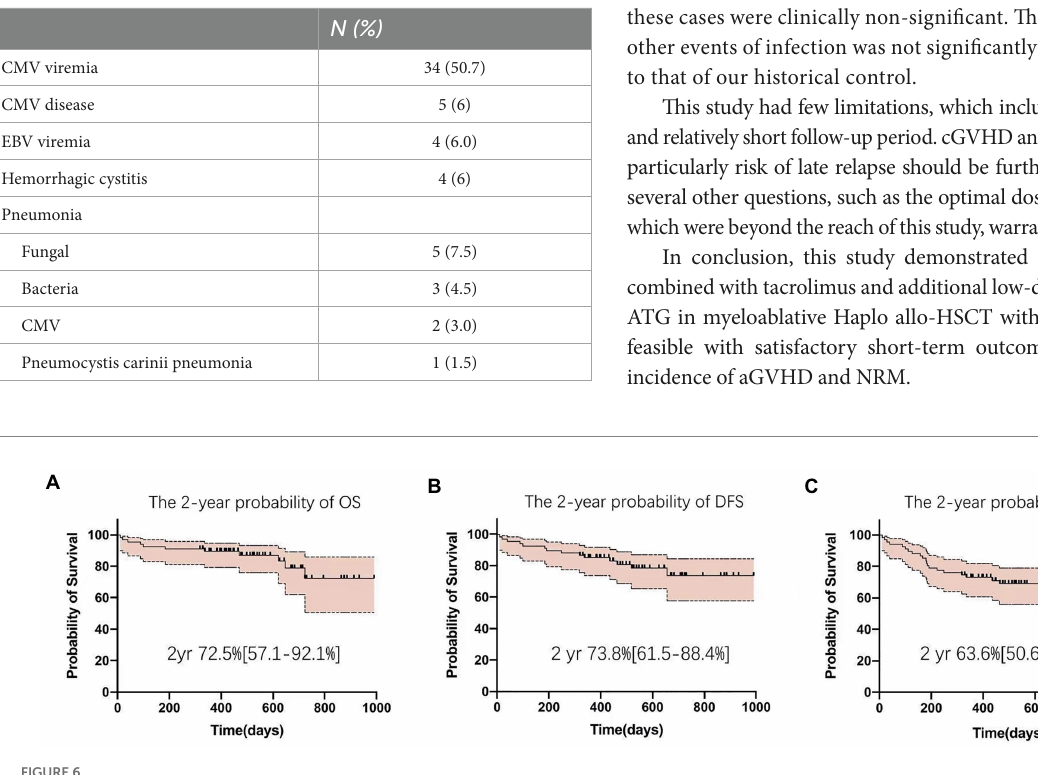
FIGURE 6 Clinical outcomes after Haplo-PBSCT. (A) The 2-year probability of disease-free survival (DFS). (B) The 2-year probability of overall survival (OS). (C) The 2-year probability of GVHD and relapse-free survival (GRFS).